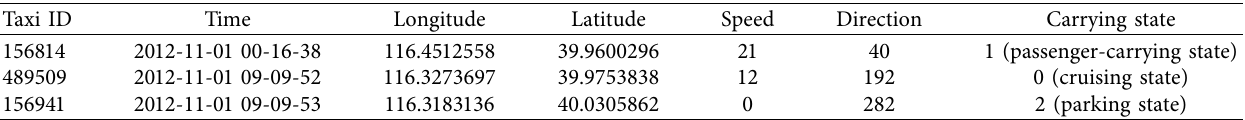
Figure 1: Study area and Table 1: Example of taxi trajectory data.